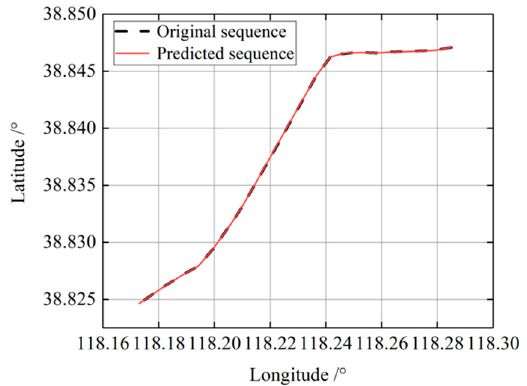
Figure 6. Comparison between predicted and original data.